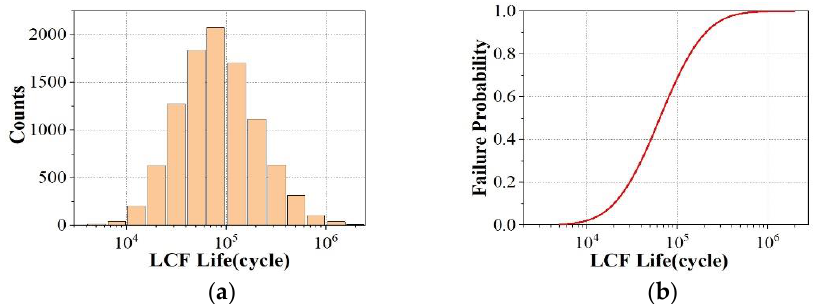
Figure 7. Results of simulation-based uncertainty analysis of the compressor disk. ( a ) Distribution histogram ( b ) Cumulative distribution function.